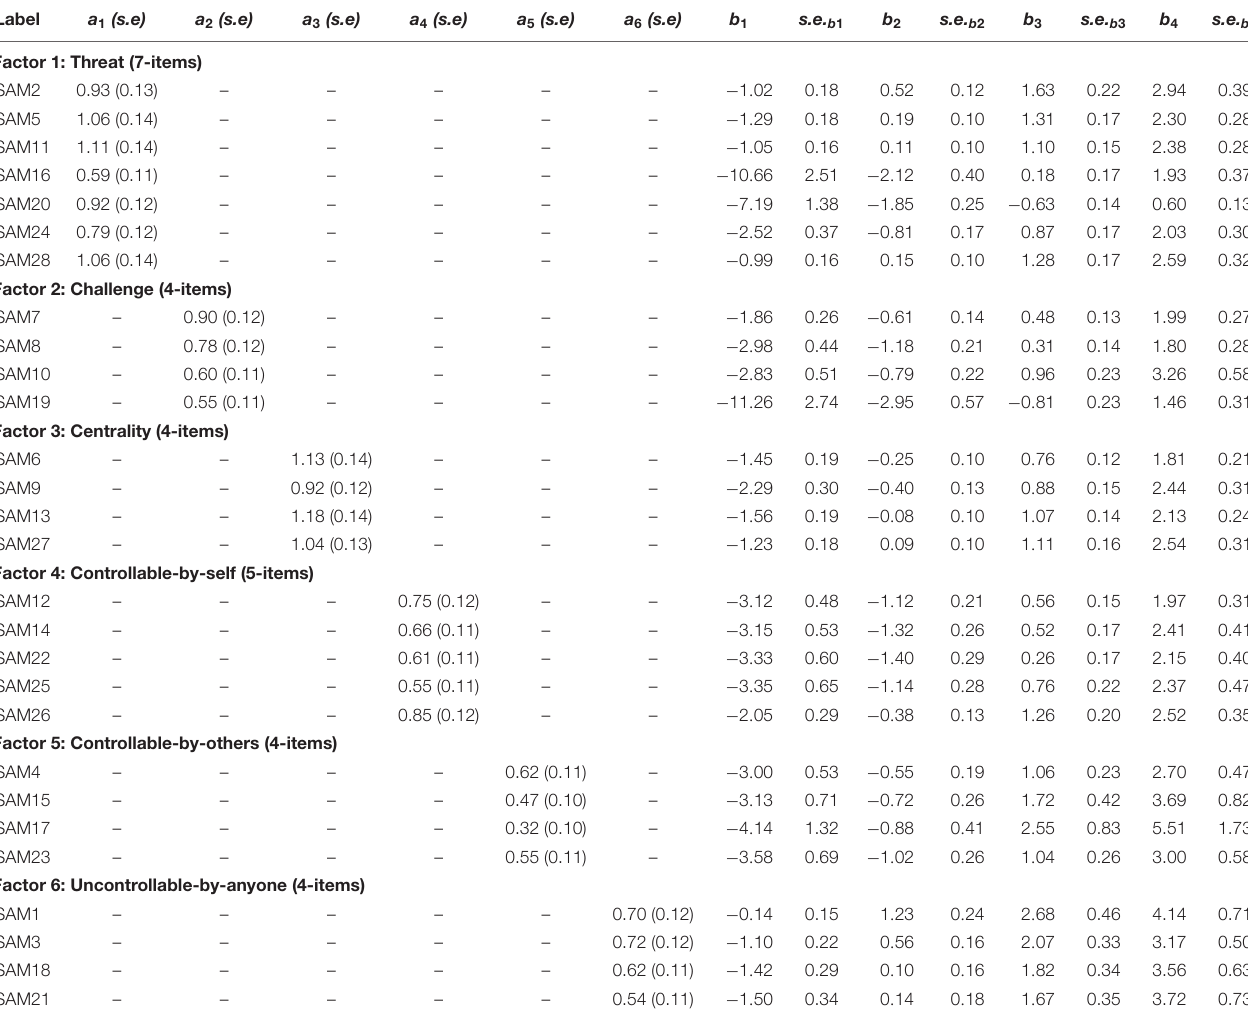
TABLE 2 | Graded model item parameter estimates, logit: a ( θ – b